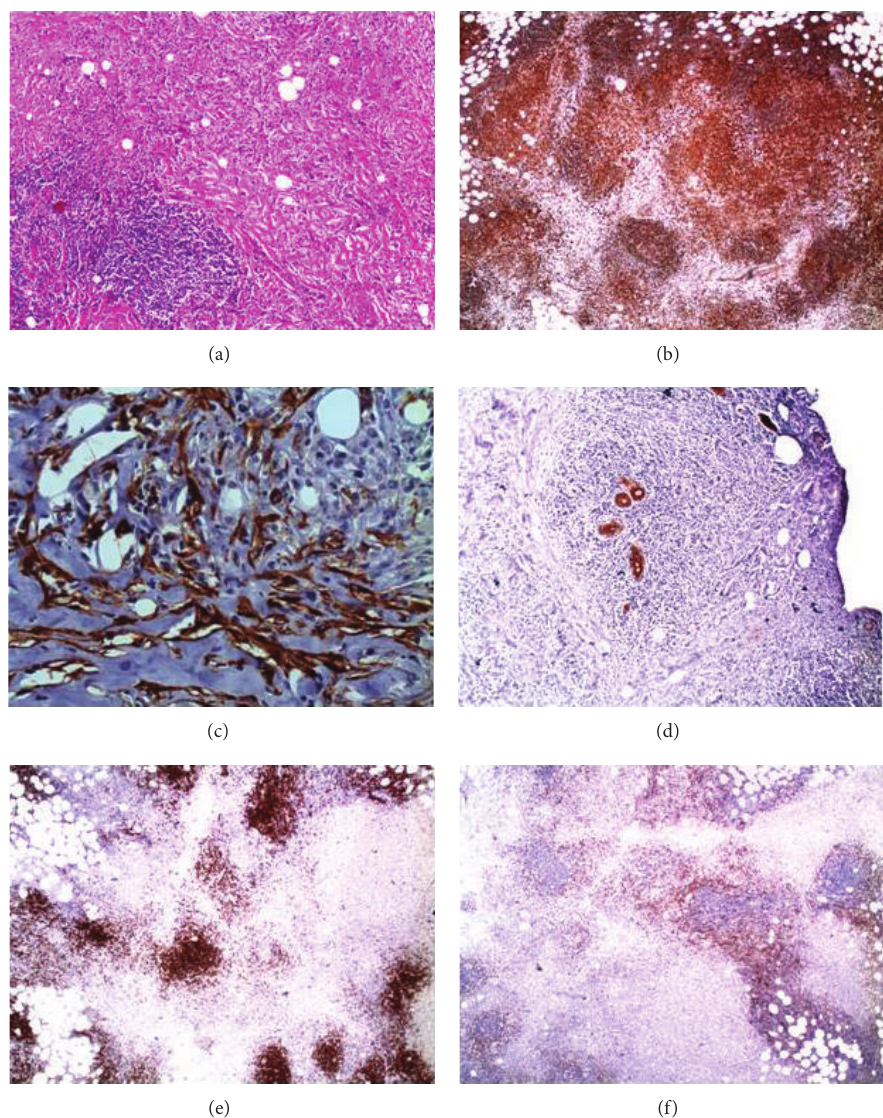
Figure 4: (a) Hematoxylin-eosin (H&E) staining of the lesion (magnification × 10): significant inflammatory invasion by lymphocytes and plasma cells; presence of stacks of fusiform myofibroblasts and few gigantic cells. (b) Vimentin staining of the lesion (magnification × 10): presence of myofibroblasts and lymphocytes. (c) Actin staining of the lesion (magnification × 40): presence of myofibroblasts which stain positive for actin. (d) Keratin 34BE12 staining (magnification × 10): myofibroblasts immunonegative to keratin 34BE12. (e) CD20 staining (magnification × 4): CD20 positive B-lymphocytes. (f) CD3 staining (magnification × 4): CD3 positive